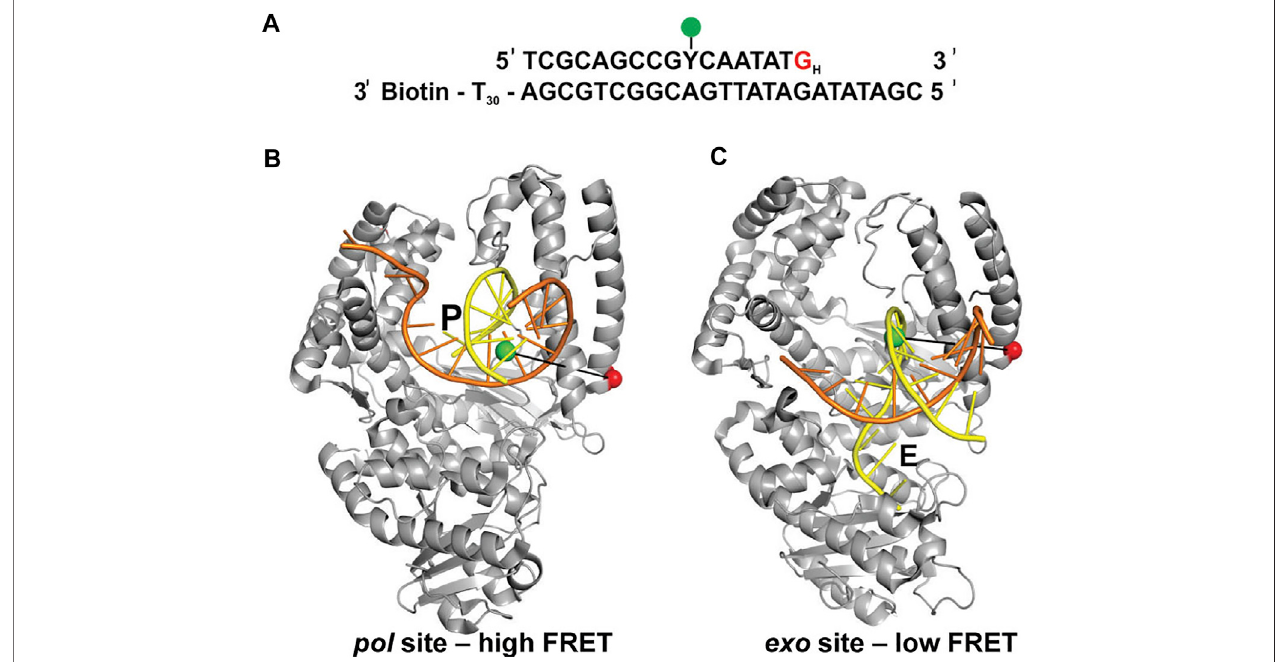
FIGURE4| FRETlabelingsystemdesignedtomonitorswitchingofDNAbetween pol and exo sitesofKF. (A) Sequenceofprimer/templatecontainingterminalG:G mismatch. (B) Crystalstructureof Bst PolIwithDNA at the pol site, P(PDB code 1L3S).Same strand colorsasin Figures1B,C . (C) Crystal structure ofKFwithDNAat the exo site, E (PDB code 1KLN). In (B,C) , the locations ofthe donor (green) and acceptor (red) are indicated. DifferentFRET ef fi ciencies are expected for DNA boundto the pol site or the exo site. Adapted from reference (Lamichhane et al., 2013) with